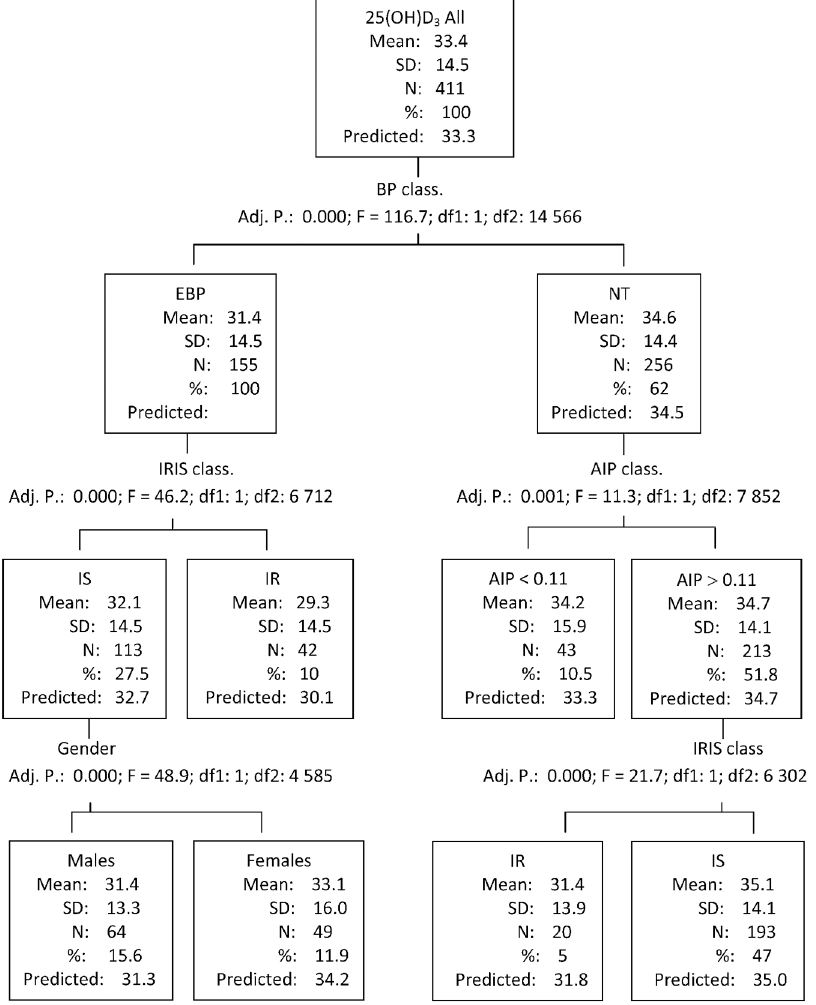
Fig 2. Decision tree. Std. Dev: standard deviation; BP: blood pressure; Adj.: adjusted; df: degree of freedom; EBP: elevated blood pressure (systolic BP (cid:1) 130 mm Hg and/or diastolic BP (cid:1) 85 mm Hg); NT: normotension; IRIS: insulin sensitivity (IS)/insulin resistance (IR); AIP: atherogenic index of plasma (AIP (cid:1) 0.11 indicates increased atherogenic risk [29])